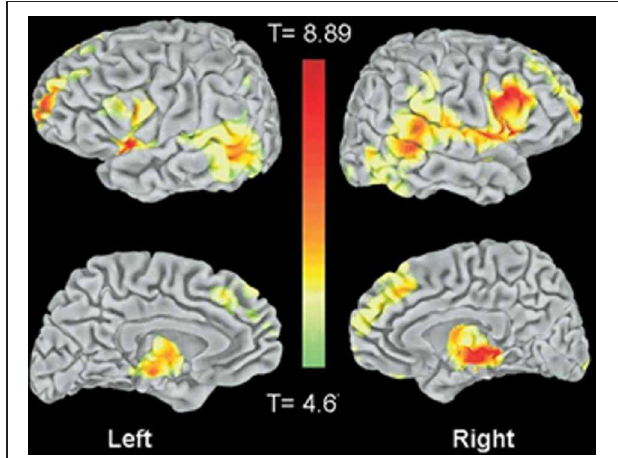
FIGURE 11 | From Honea et al. (2008) showing data from a large morphometric study using 169 patients with schizophrenia-spectrum disorders and 212 control subjects Statistical maps of the entire brain showing gray matter volume reductions in schizophrenics versus control subjects. Figure 1 panel A reprinted with permission from Honea et al. (2008). © 2008 Society of Biological Psychiatry.